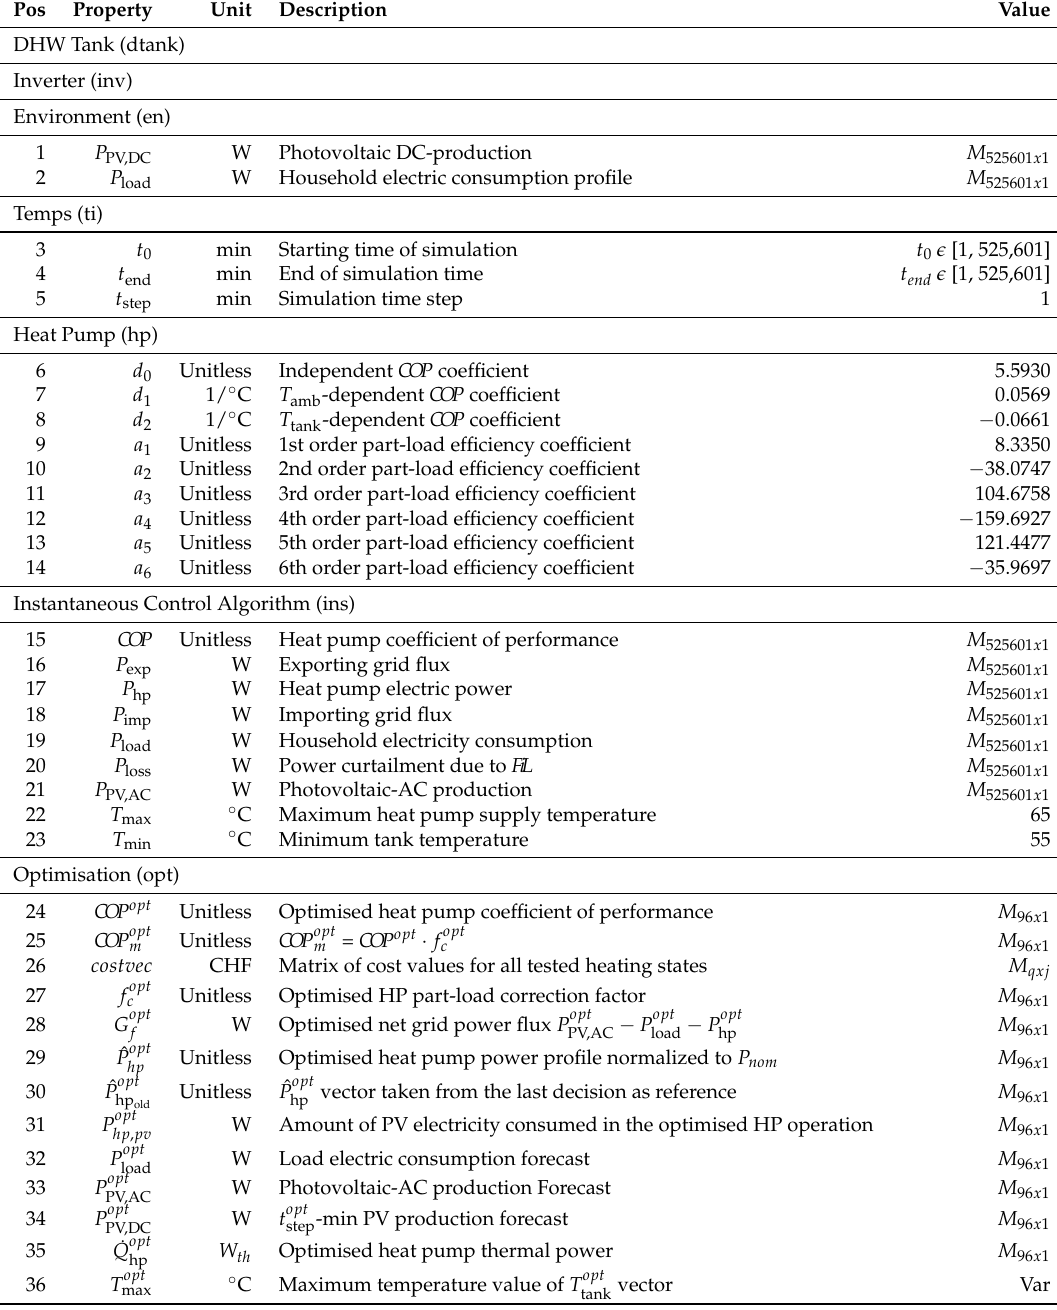
Table A1. Definition of MATLAB main classes, parameters and variables used in the simulation. Pos Property Unit Description Value DHW Tank (dtank) Inverter (inv) Environment